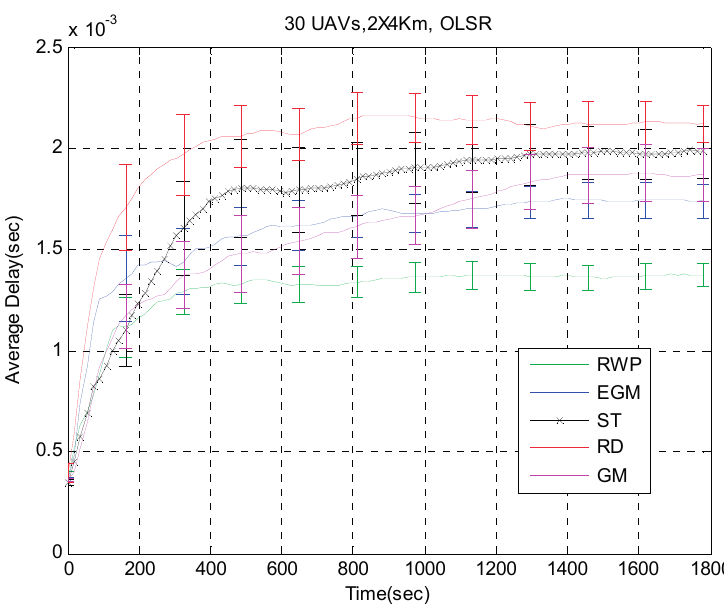
Figure 16. End-to-end delay of OLSR under various mobility